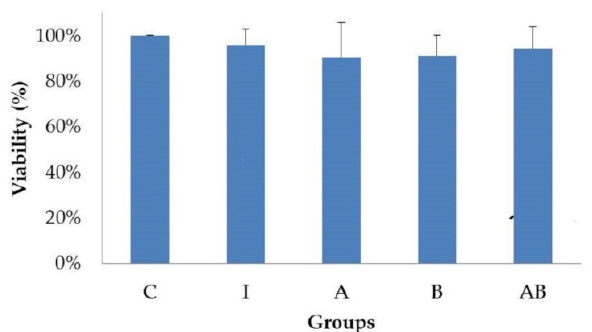
Figure 2. Effects of pro-inflammatory factors and probiotics on viability of HT-29 cells. All values except for control are mean ± SD (n = 3). There is no significant difference among groups determined by Duncan’s multiple range test, p < 0.05. C, control; I, TNF- α (20 ng/mL) with LPS (1 μ g/mL); A, L. acidophilus at MOI of 1 with TNF- α (20 ng/mL) and LPS (1 μ g/mL); B, B. animalis subsp. lactis at MOI of 10 with TNF- α (20 ng/mL) and LPS (1 μ g/mL); AB, L. acidophilus at MOI of 1 and B. animalis subsp. lactis at MOI of 10 with TNF- α (20 ng/mL) and LPS (1 μ g/mL). Control group is used as the reference.